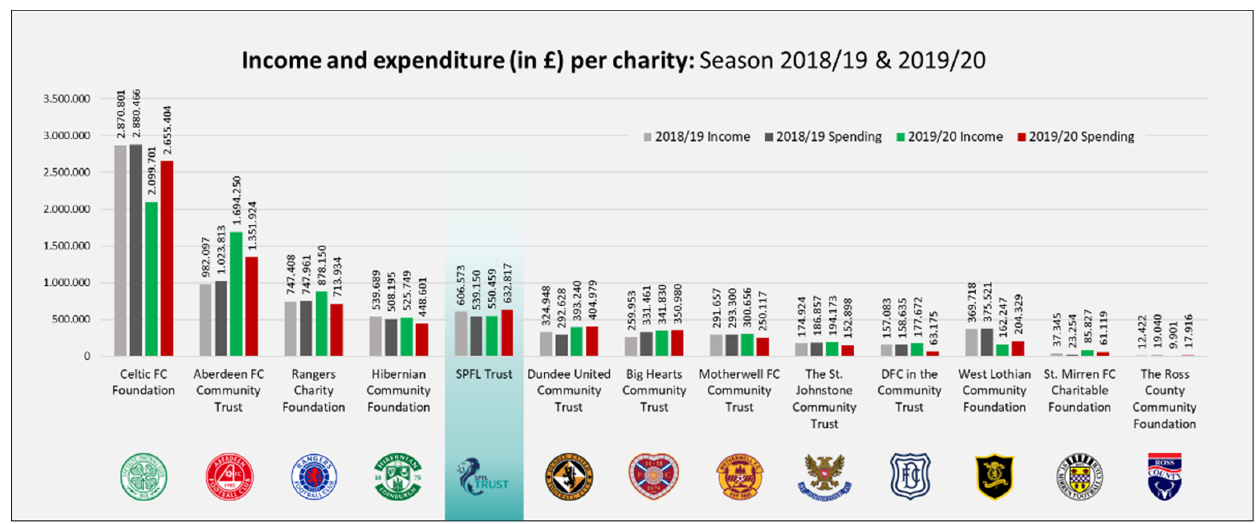
Figure 5. Financial performance of the charities (based on OSCR’s publicly available figures).